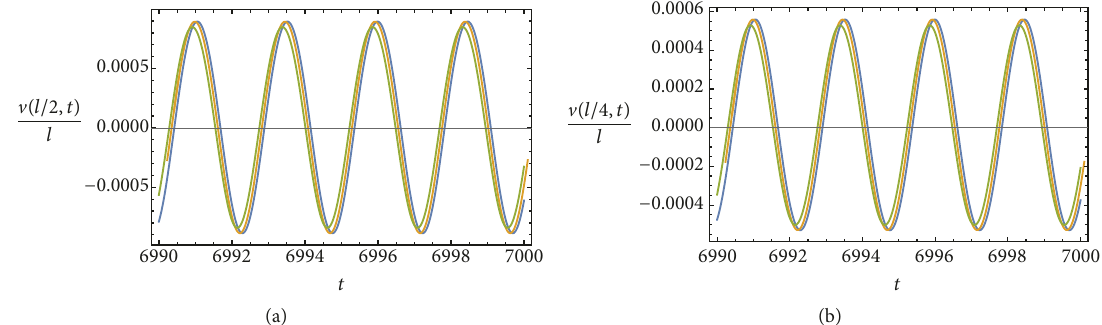
Figure 4: Case-study 1: reconstituted time evolution of the displacement V (𝑠,𝑡) for 𝑈 2 /𝑈 𝑐 = 0.11 at (a) half-span and (b) quarter-span (green line: multiple scale method; blue line: Galerkin method; orange line: finite difference method).